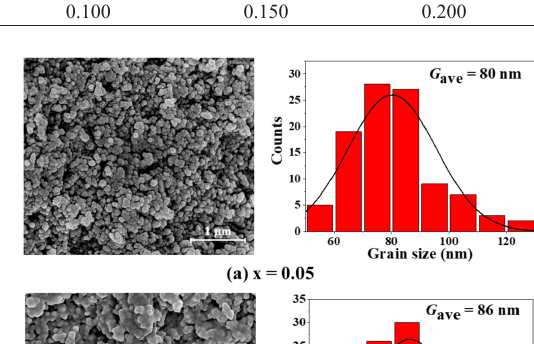
), weighted profile factor (R ), exp wp K concentration x = 0.05